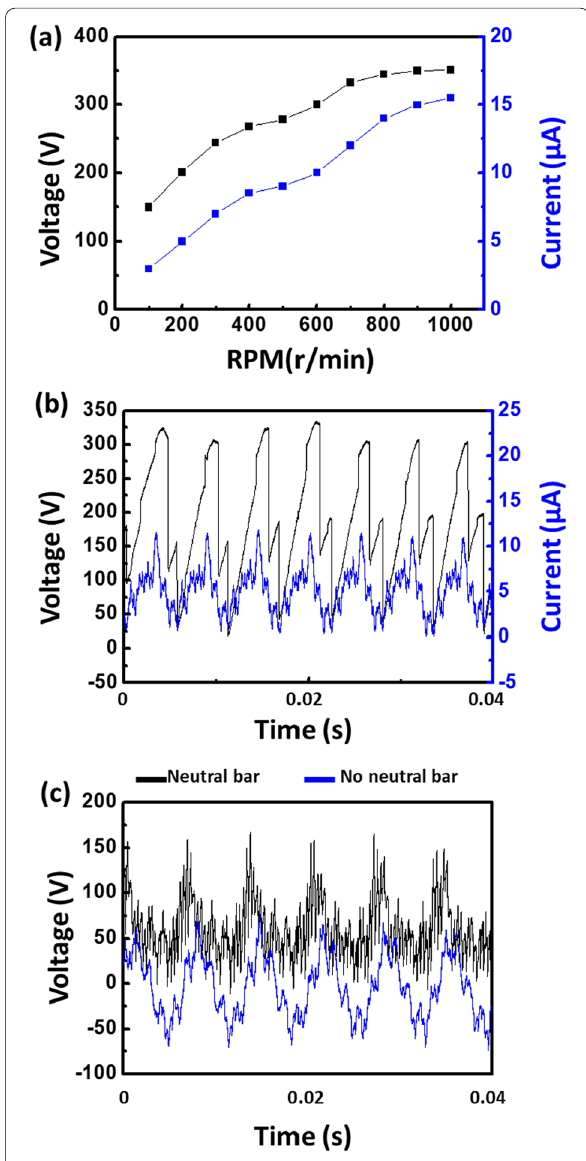
Fig. 3 Performance characterization of the rotation‑type TENG. a The output voltage and current of the TENG as a function of rotation. b Time evolution of the TENG’s output at 800 rpm. c TENG’s output voltage with and without the neutral